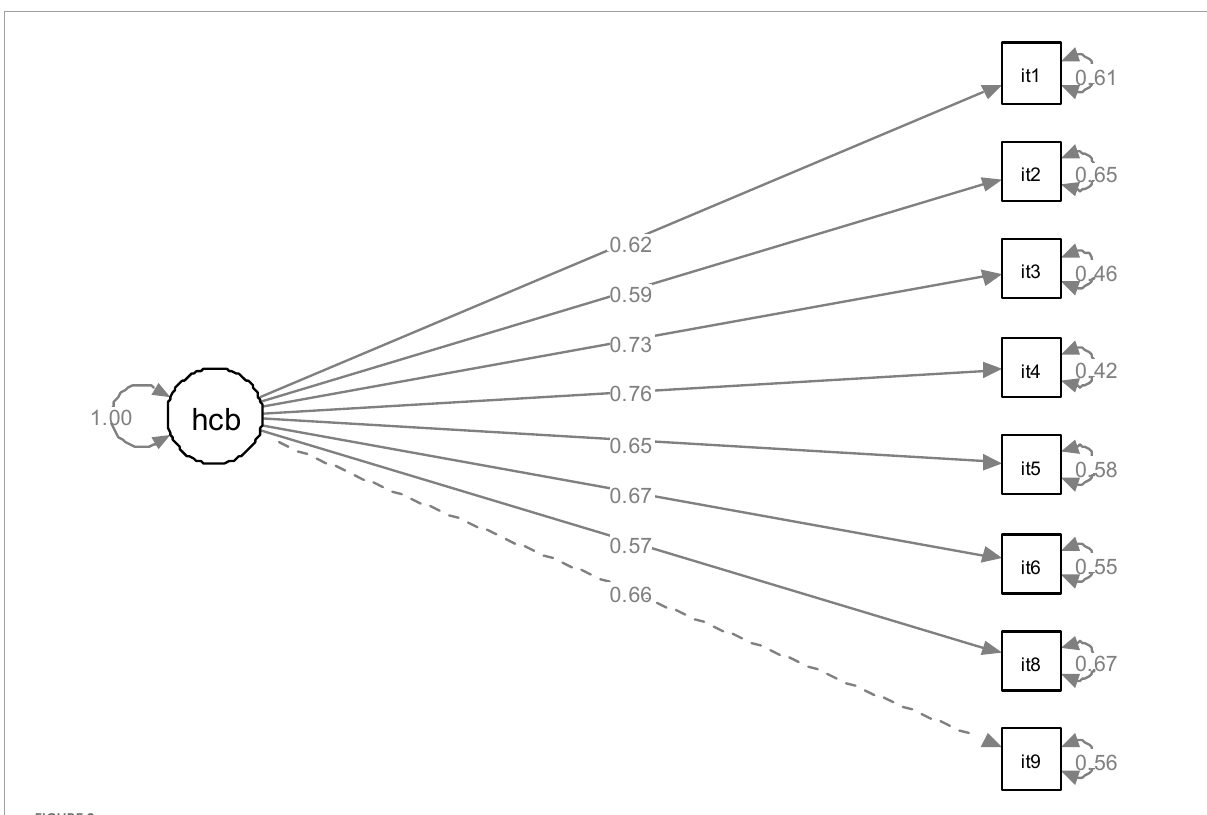
FIGURE2 The standardized solution for HCBS eight-item model. hcb, homework creativity behavior; it 1 ∼ 9, item1 ∼ 6, 8 ∼ 9.